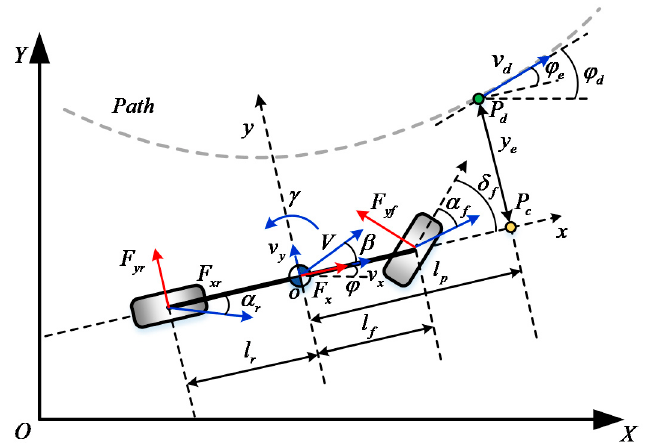
Figure 1. Schematic of path following system. OXY is the global coordinate system and oxy is the vehicle body-fixed local coordinate system.